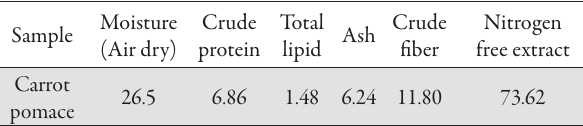
Tab. 1. Chemical composition of carrot pomace as (g/100 g) dry weight basis